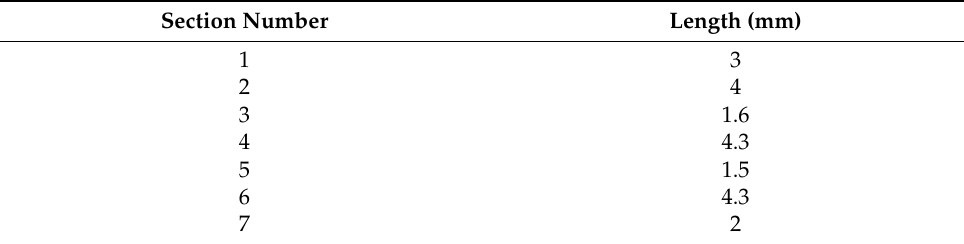
Figure 8. Structure diagram of the Bragg reflector. Table 1. Dimensions of the Bragg